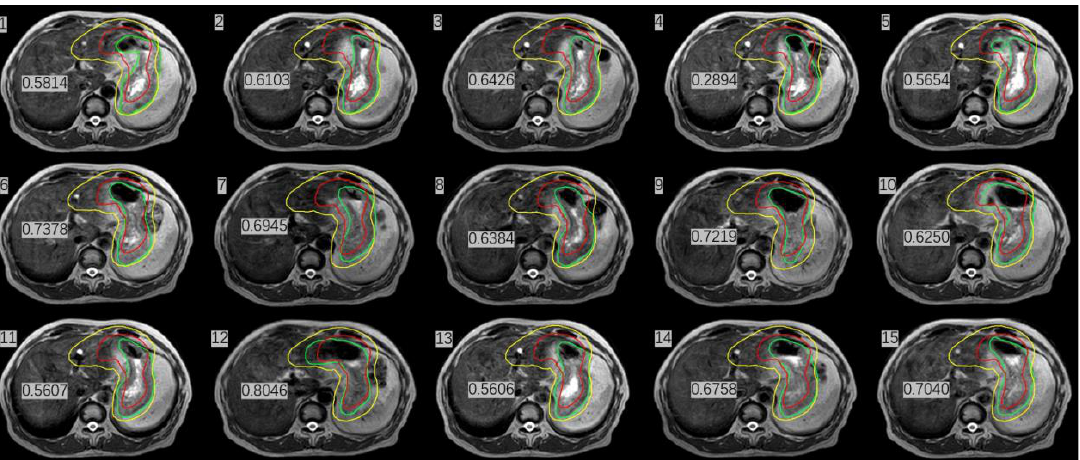
Figure 4. Stomach delineation DSC (number in Figure) of real-time MR imaging and simulation CT imaging the (red line delineates the stomach on the simulation images, the green line delineates the stomach on the daily MRI images, and the yellow line delineates the stomach considering 1 cm external expansion from the iCTV). Table 1. Dose of OAR in CT simulation and MRI-guided therapy.